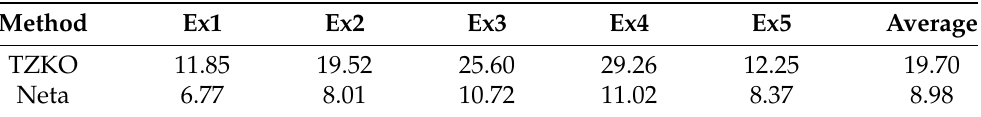
Table 3. Average number of function evaluations per point for each example (1–5) and each of the methods.